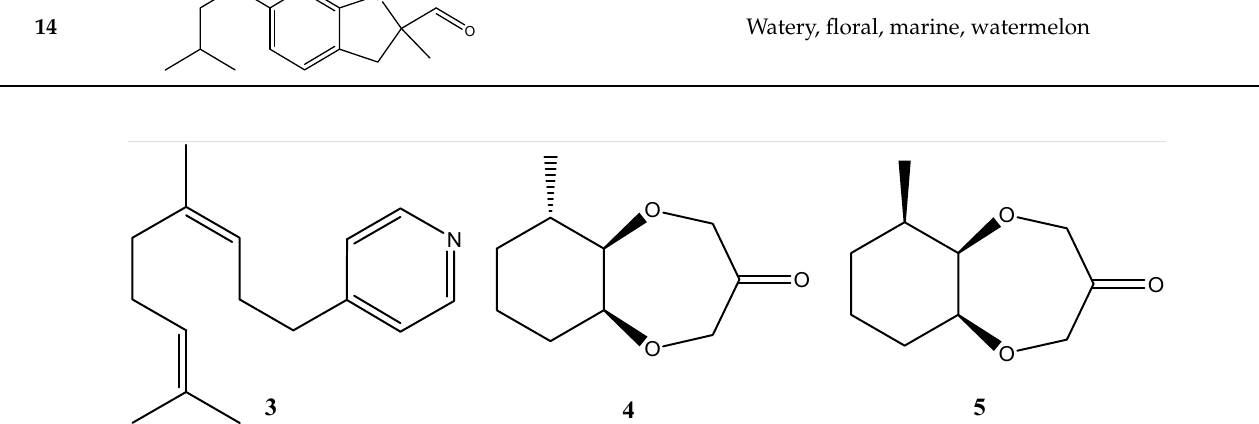
Figure 4. Specific compounds exhibiting marine odor. Table 2. Olfactory profile of five-membered ring compounds .